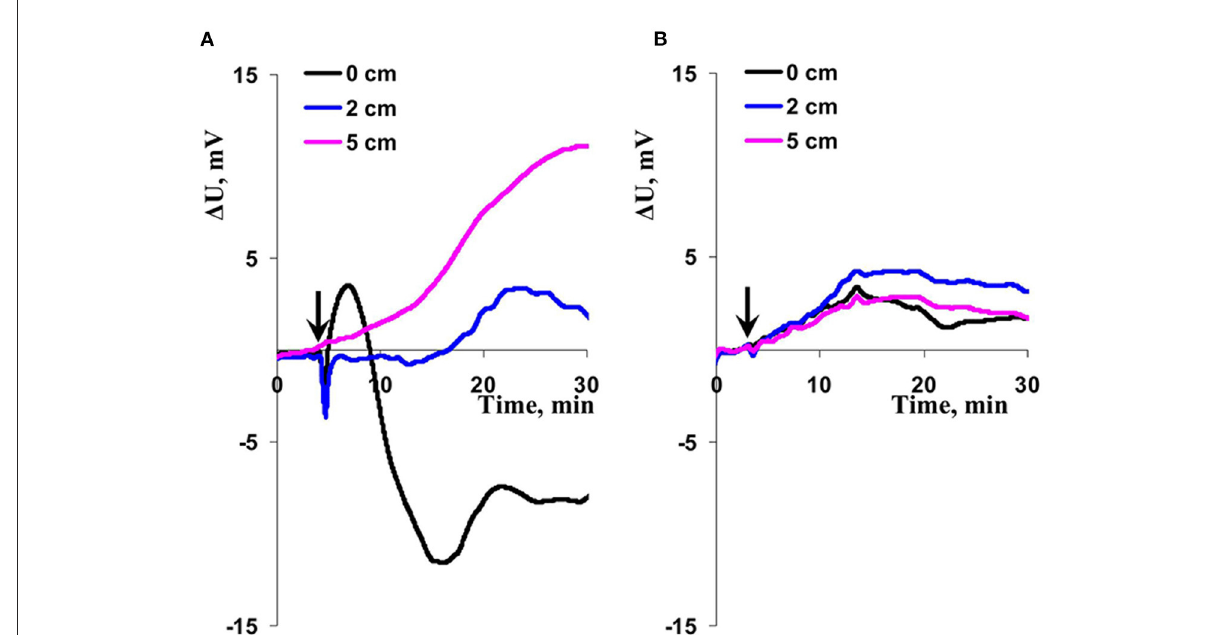
FIGURE6 Records of changes in the surface potential ( 1 U) induced by action of local illumination (A) and heating (B) in wheat plants. The extracellular measuring electrodes contacted to the second wheat leaf on 0 (border of this zone), 2, and 5cm from the irritated zone. The blue light (540 µ mol m − 2 s − 1 ) or the heating (40 ◦ C) locally acted the top of the second wheat leaf; initiation of this action is marked by